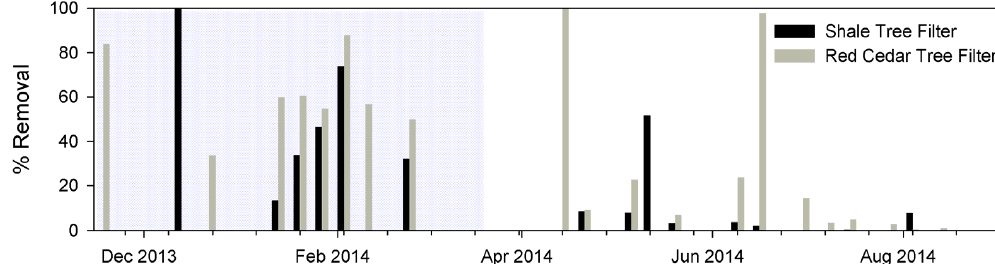
Figure 5. Comparison of polycyclic aromatic hydrocarbons (PAH) removal percentages achieved by the two different filter units over the course of the sampling period. The gray area indicates the period during which snow was present and therefore the influent consisted of a combination of runoff and snowmelt.